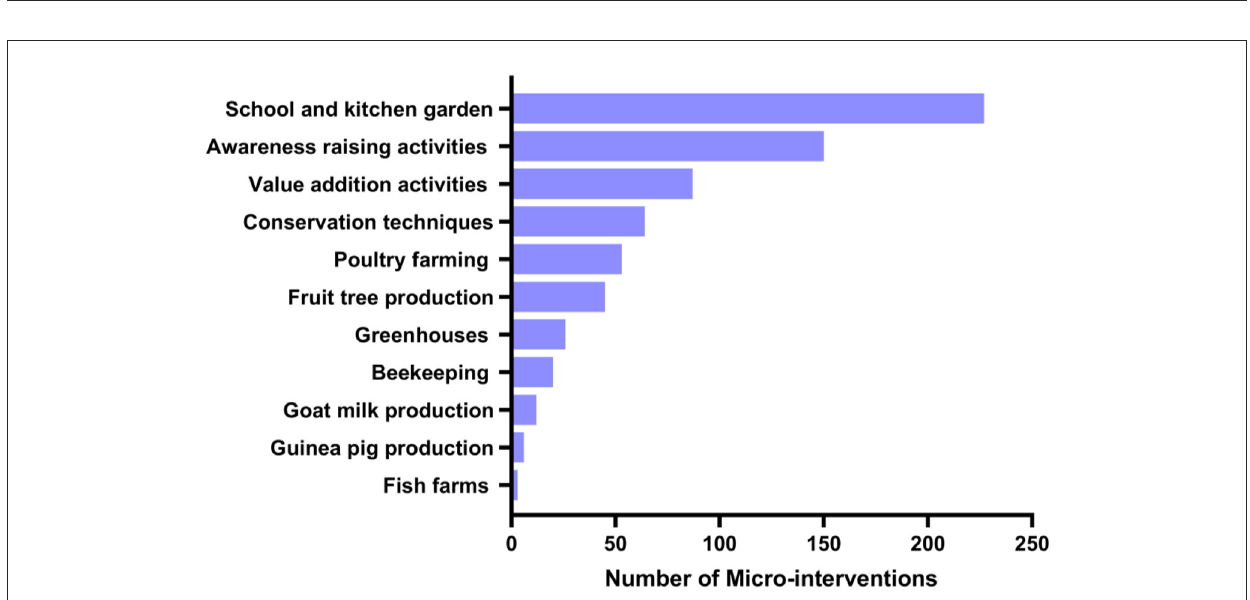
FIGURE3 Main focus of micro-interventions implemented by service providers in both the project phases (2015–2021).